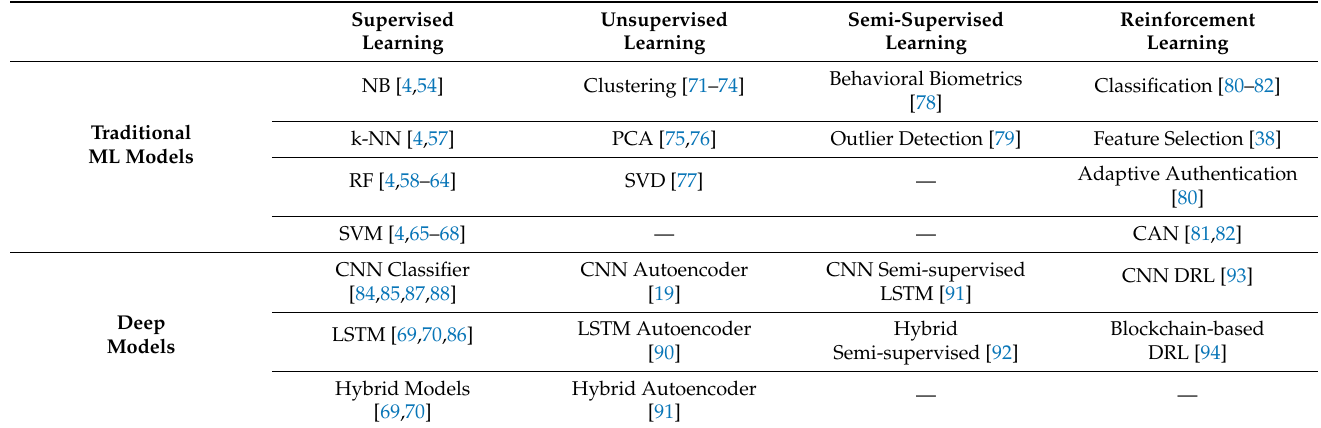
Table 1. Categorization of the traditional ML and deep ML models and examples for further study. Supervised